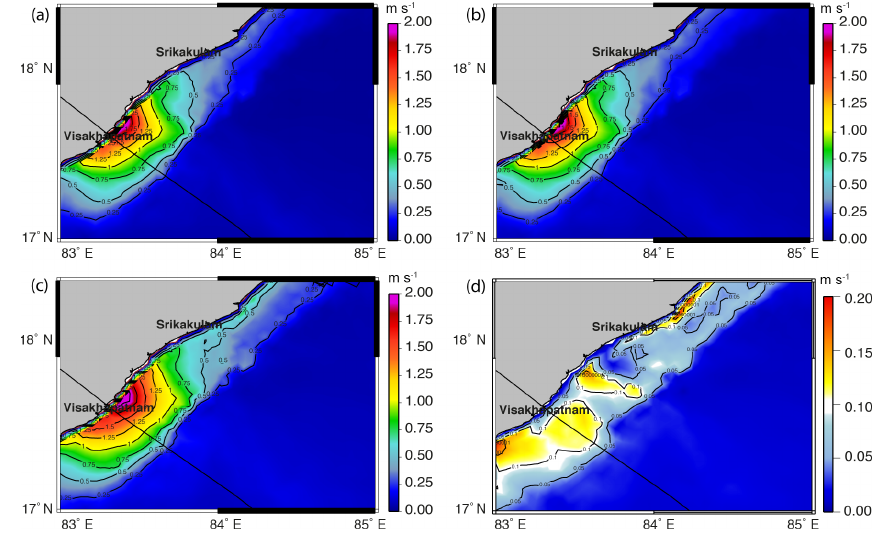
Figure 5. Spatial distribution of maximum surface currents (metres per second) due to (a) winds, (b) winds and tides and (c) winds, tides and waves during cyclone. (d) Difference in current speeds from (b) and (c) , illustrating change in current speeds due to wave–current interaction (colour code represents current speeds in metres per second).